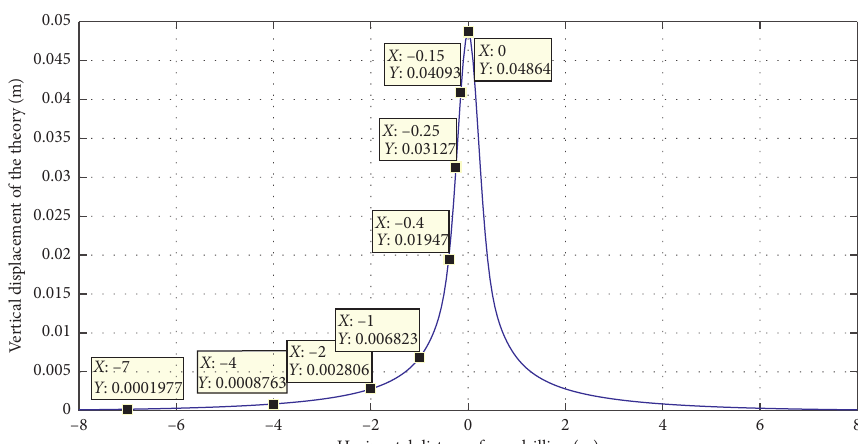
Figure 6: The calculated vertical displacement of the ground surface after conducting a single HPJG according to provisional